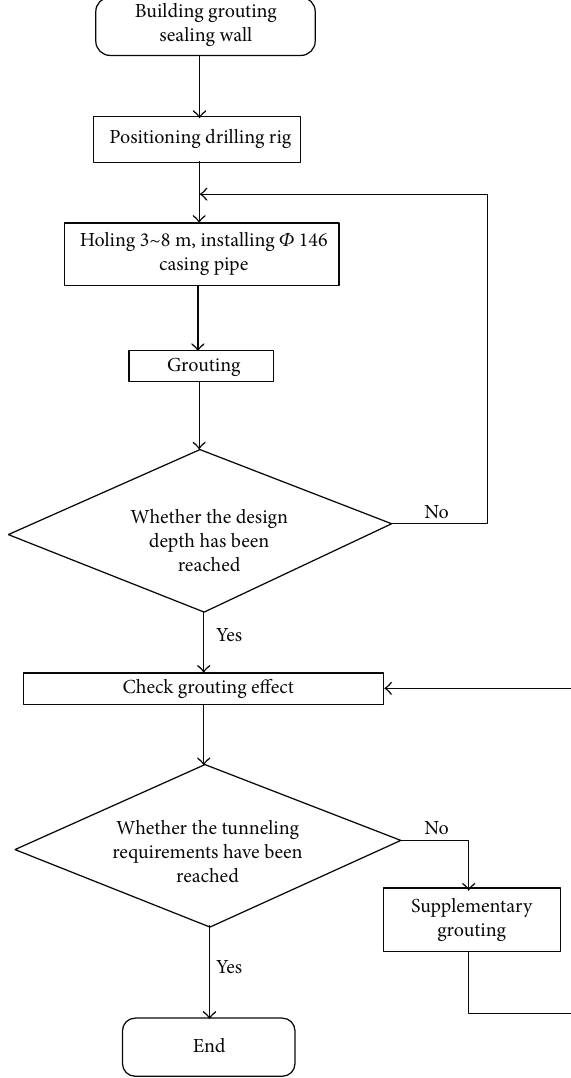
Figure 6: Process of curtain grouting in Junchang